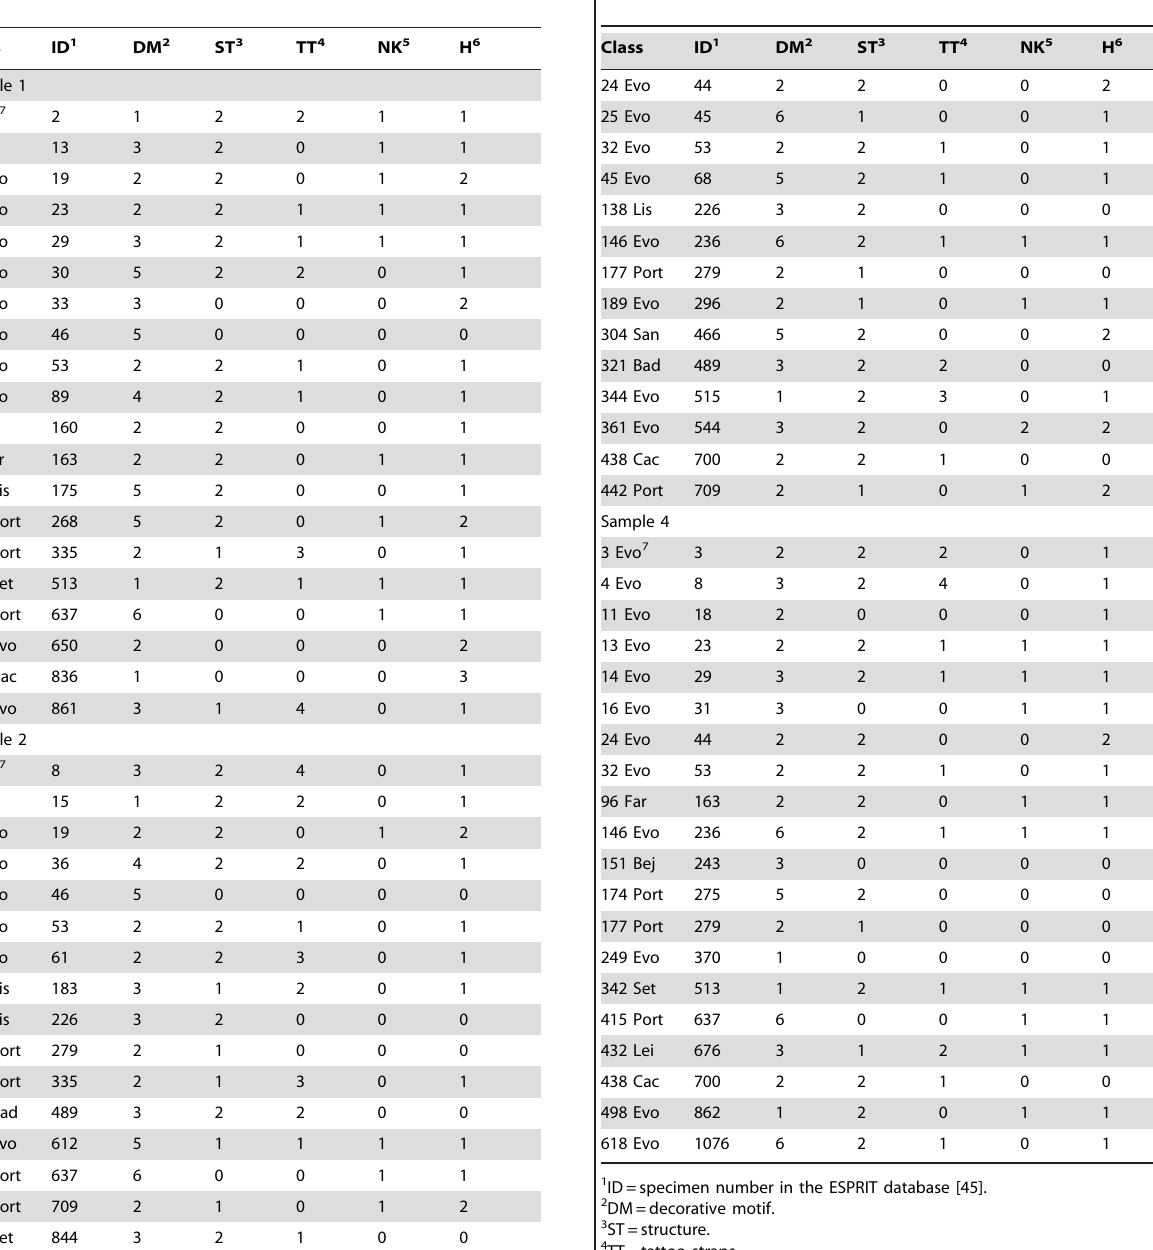
Table 4. Data matrix for the four samples.